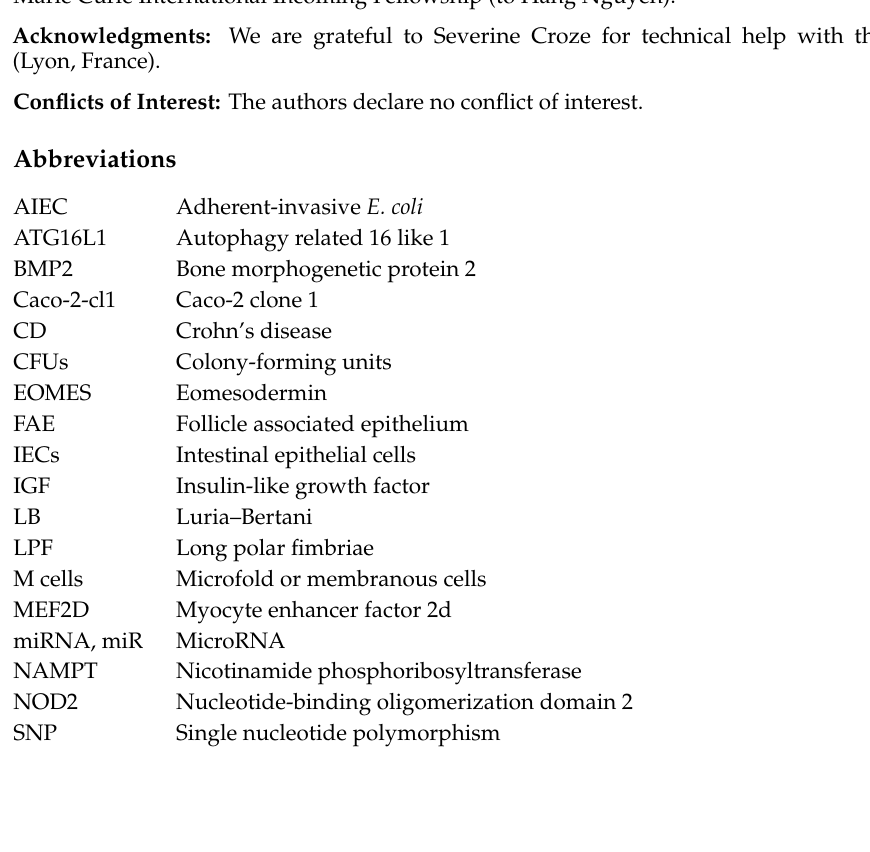
Figure S1: Classification into pathways of the dysregulated genes in LF82-infected vs. uninfected Caco-2-cl1 cells that were potentially regulated by miRNAs, Figure S2: Classification into pathways of the dysregulated genes in LF82-infected versus uninfected M cells that were potentially regulated by miRNAs, Table S1: Dysregulated miRNAs in uninfected M cells compared to uninfected Caco-2-cl1 cells, Table S2: Potential target genes of dysregulated miRNAs in uninfected M cells compared to uninfected Caco-2-cl1 cells, Table S3: Dysregulated genes in uninfected M cells versus uninfected Caco-2-cl1 cells, Table S4: Dysregulated genes in uninfected M cells compared to Caco-2-cl1 cells that were potentially regulated by miRNAs, Table S5: Dysregulated miRNAs in AIEC LF82-infected versus uninfected Caco-2-cl1 cells, Table S6: Dysregulated miRNAs in AIEC LF82-infected versus uninfected M cells, Table S7: Potential target genes of dysregulated miRNAs in LF82-infected compared to uninfected Caco-2-cl1 cells, Table S8: Potential target genes of dysregulated miRNAs in LF82-infected compared to uninfected M cells, Table S9: Dysregulated genes in AIEC LF82-infected versus uninfected Caco-2-cl1 cells, Table S10: Dysregulated genes in AIEC LF82-infected versus uninfected M cells, Table S11: Genes that were dysregulated in both Caco-2-cl1 cells and M cells upon AIEC LF82 infection, Table S12: Dysregulated genes in LF82-infected versus uninfected Caco-2-cl1 cells that were potentially regulated by miRNAs, Table S13: Dysregulated genes in LF82-infected versus uninfected M cells that were potentially regulated by miRNAs, Table S14: Genes that were dysregulated in both Caco-2-cl1 cells and M cells upon AIEC LF82 infection and were potentially targeted by